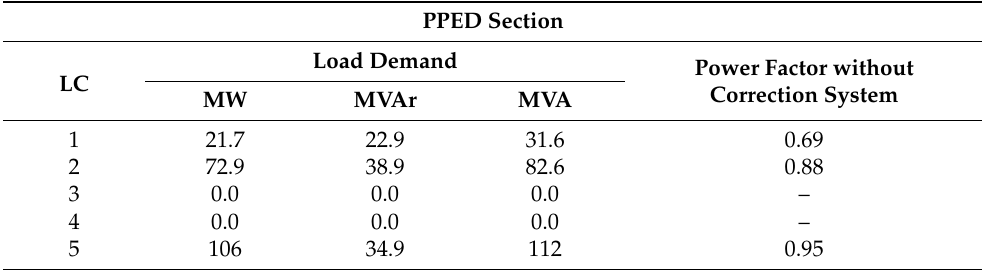
Table 4. Active, reactive and apparent power required by DTT distribution LCs, PPED section.